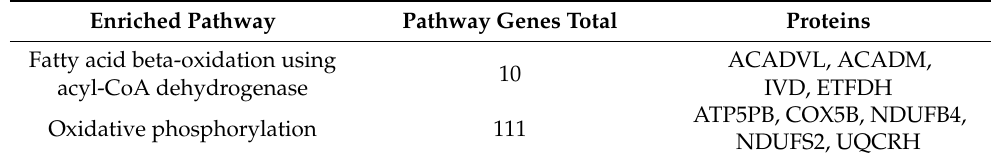
threshold, which was 1.3. Table 2. Signi fi cantly ( p ≤ 0.05) di ff erentially abundant proteins included in signi fi cantly ( p ≤ 0.05) enriched pathways in CD4 − PBMCs of GHR -KO pigs ( n = 4) compared to WT pigs ( n = 5). Table 2. Significantly ( p ≤ 0.05) differentially abundant proteins included in significantly ( p ≤ 0.05)